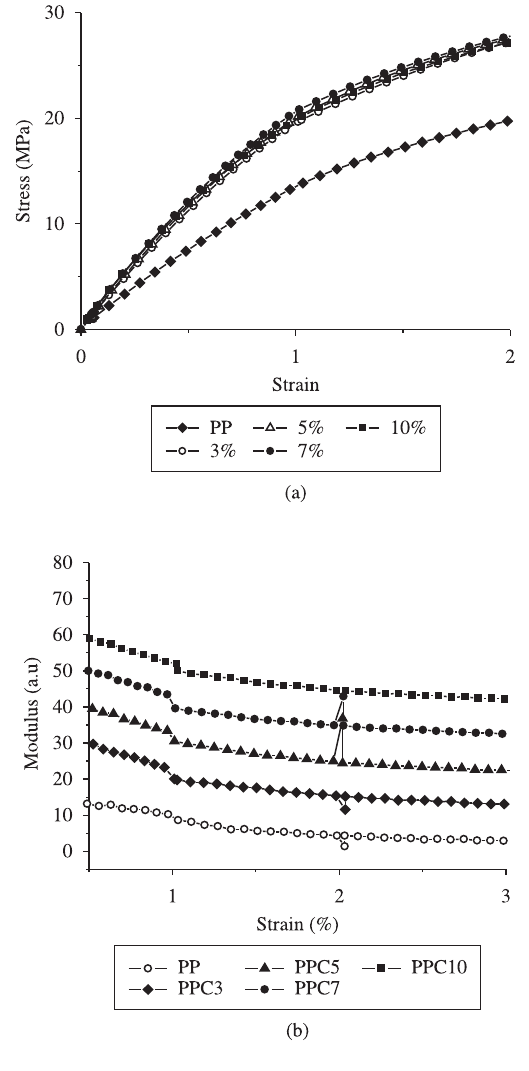
Figure 6. a) Stress × Strain curves of neat PP and the nanocomposites for small deformations and b) Derivative plot of the stress × strain curves. The symbols were used to differentiate the